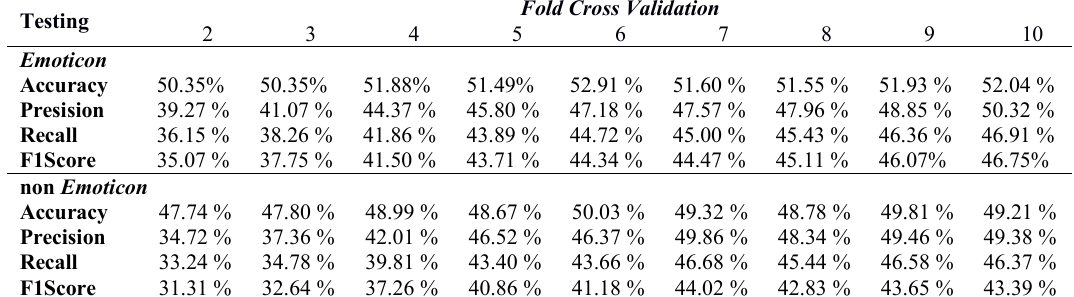
TABLE 4 T HE MEASURE OF THE QUALITY OF SENTIMENT ANALYSIS USING THE NAÏVE BAYES CLASSIFIER METHOD